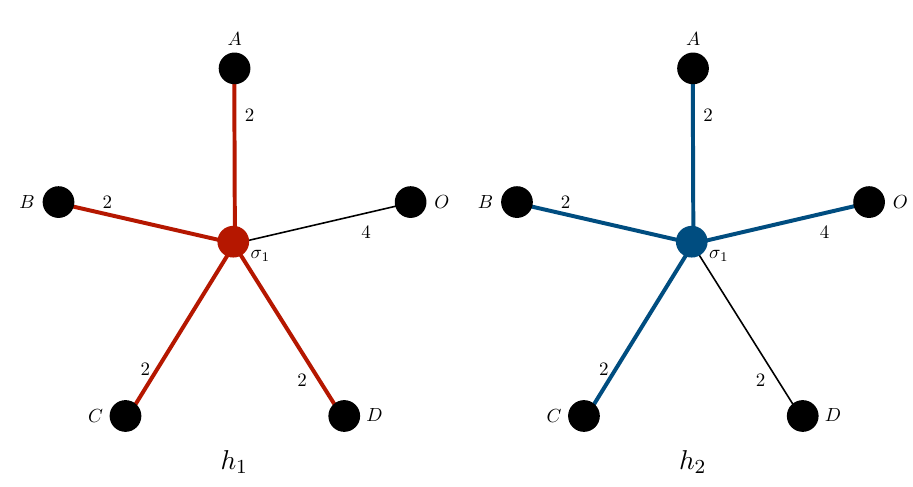
Figure 21 . The thread configuration consists of two classes of threads h 1 and h 2 which are collec- tions of thread species which respect a symmetry of the graph. h between ABCD . h consists four positive 4-threads one between each of ABCO, ABDO, ACDO 2 and BCDO . We write this collection of regions more succinctly as ( ABCD ) ABCO 4-thread as a representative of the